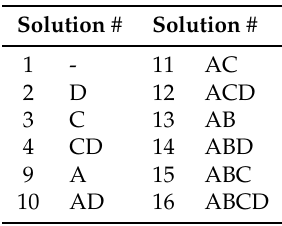
Table 3. Solutions for the search algorithm example depicted in Figure